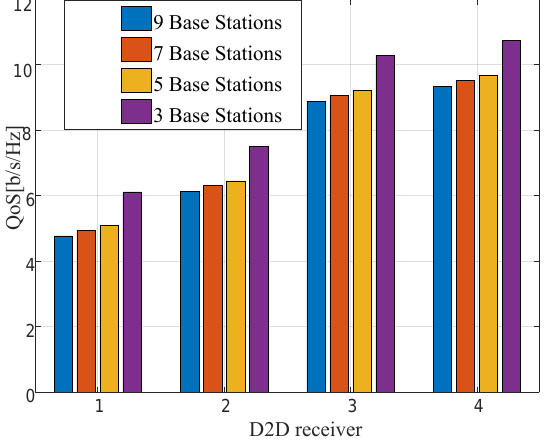
Figure 5. QoS of each D2D user in various number of